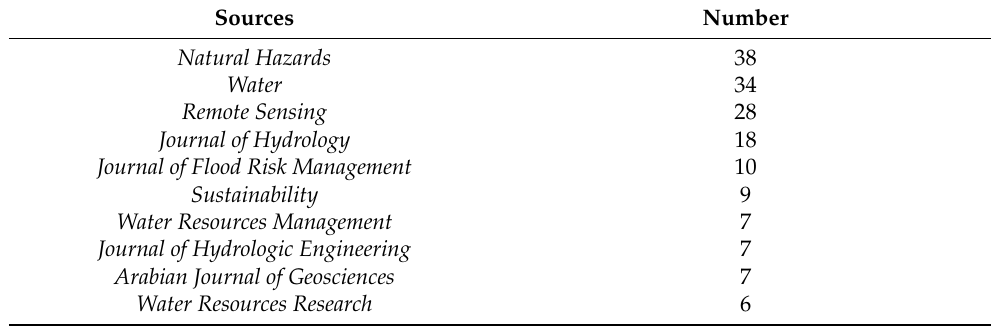
Figure 2. Number of documents per publication year. Table 2. Top 10